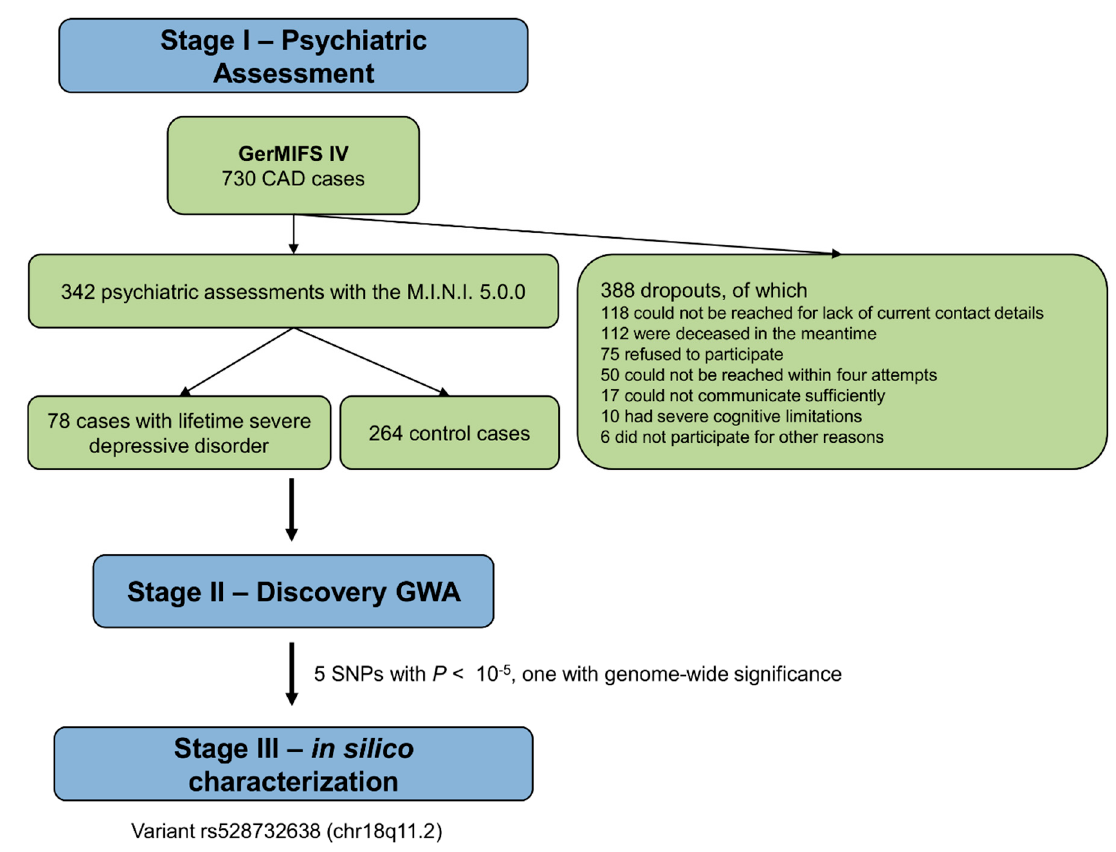
Figure 1. Graphical depiction of the stepwise study design. GerMIFS: German Myocardial Infarction Study; CAD: coronary artery disease; M.I.N.I.: Mini International Neuropsychiatric Interview; severe depressive disorder: severe Major Depressive Episode and/or Dysthymia; GWA: genome-wide association; chr: chromosome; SNP: single nucleotide polymorphism.